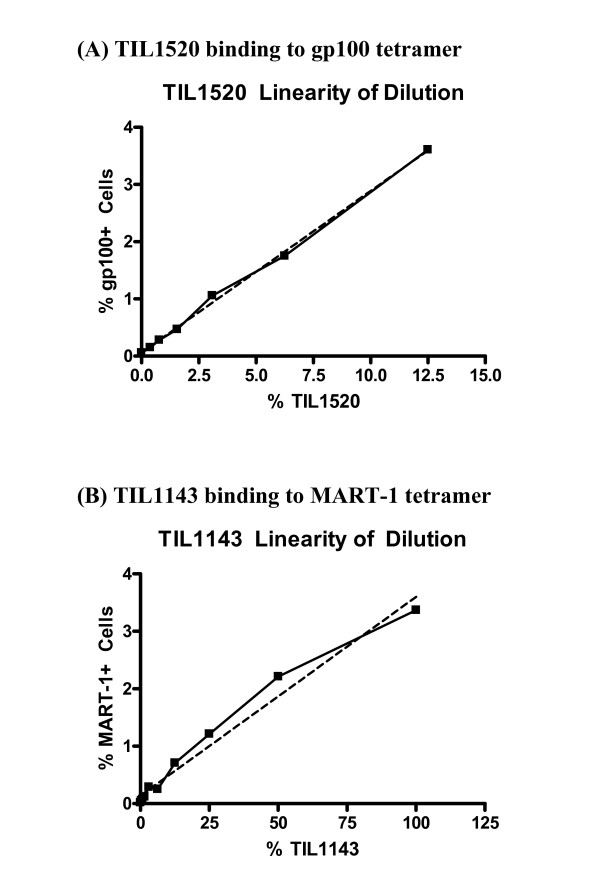
Tetramer assay linearity of dilution. (A) TIL1520 binding to gp100 tetramer. Correlation of % TIL1520 used (x-axis) vs. % gp100 tetramer positive cells detected (y-axis) is shown. (B) TIL1143 binding to MART-1 tetramer. Correlation between % TIL1143 used (x-axis) vs. % MART-1 tetramer positive cells (y-axis) is illustrated.